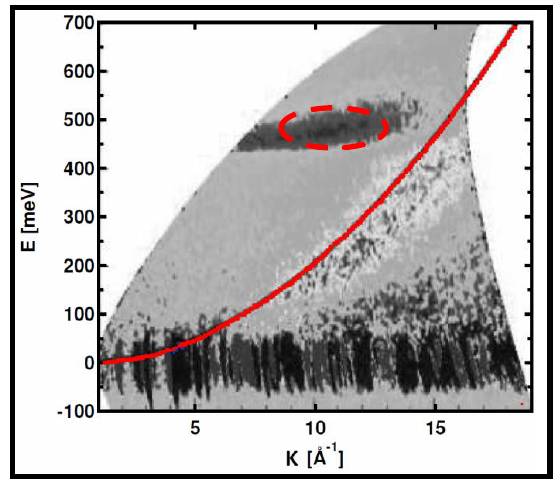
Figure 7. INS from oriented single H 2 O molecules in sub-nanometer channels of beryl (chemical formula Be 3 Al 2 Si 6 O 18 ) at T = 7 Kelvin [29], investigated with the TOF-spectrometer SEQUOIA of SNS, Oak Ridge Nat. Lab., Oak Ridge, TN, USA. Neutron incident energy was E 0 = 800 meV. The figure shows the difference of two measured S ( K , E ) maps: (i) for K -perpendicular-to- c and (ii) for K -parallel-to- c orientation. Red parabola line: the calculated recoil trajectory of a free proton. The strong intensity peak at energy transfer 450–500 meV (marked with the ellipsoid, red broken line) are the well-known stretching OH vibrational modes, which exhibit a strong momentum-transfer deficit effect [21]. The molecules are oriented with their H–H direction parallel to the c -axis of the crystal’s channels. (Adapted from of [29]; see also